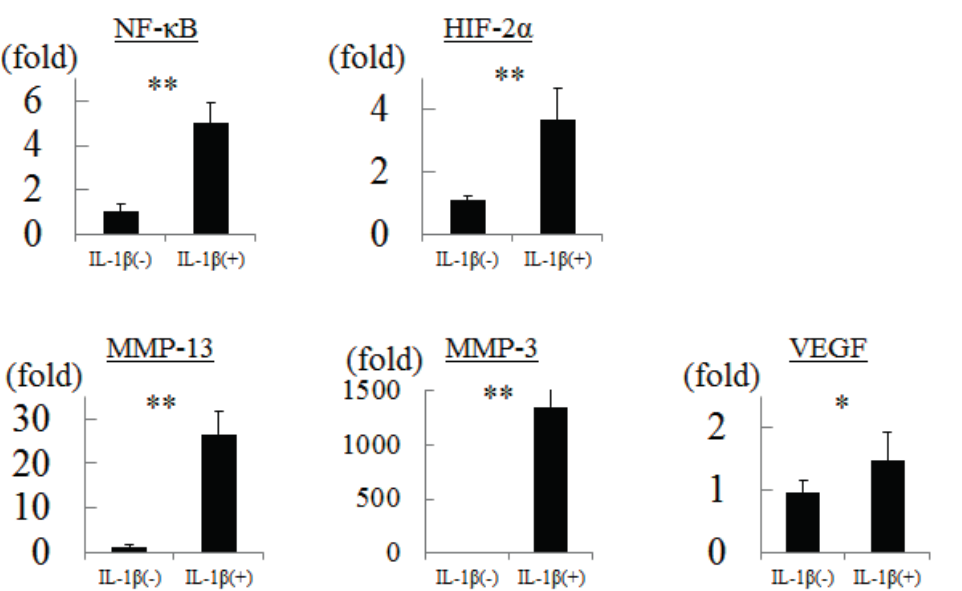
Figure 1. Gene expressions in chondrocytes after interleukin-1 β stimulation. * p < 0.05, ** p < 0.01.